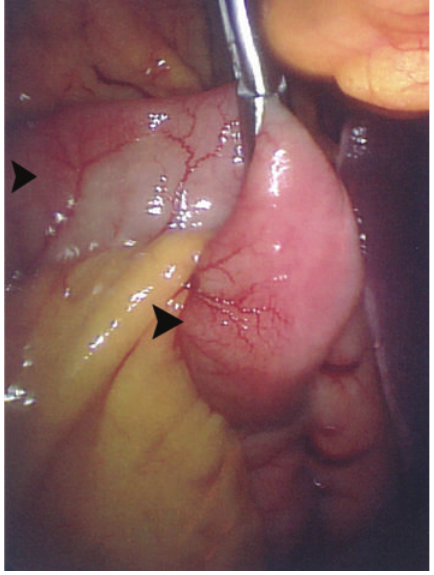
Figure 4: Laparoscopic evaluation of the patient revealed skipped areas of serosal inflammation involving the small bowel and to a lesser degree the colon. This view of the biopsied part of jejunum reveals an area of hyperemia and dilated blood vessels indicating an inflammatory process